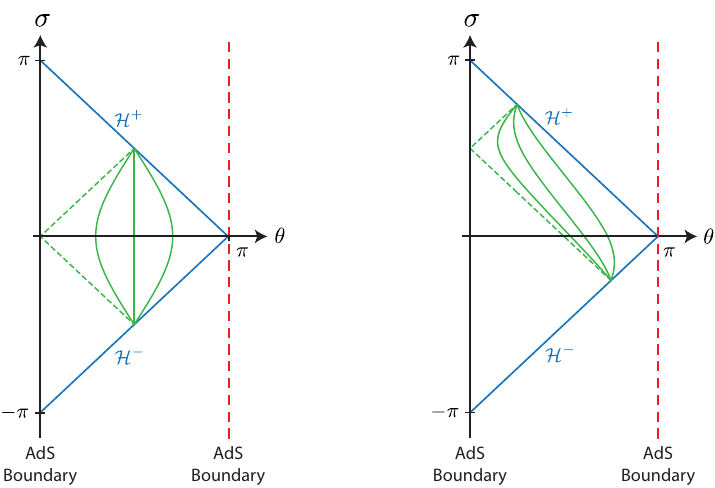
Figure 8 . Null geodesics in (4.7) in the ( (cid:27); (cid:18) ) plane describing the AdS 2 sector. The left diagram is for t 0 = 0 while the right t 0 = 1. For each case we have plotted several geodesics obtained by taking di(cid:11)erent values of ~x ? . As j ~x ? j goes to in(cid:12)nity, the geodesics get closer to the Poincare horizon H (cid:6) of AdS 2